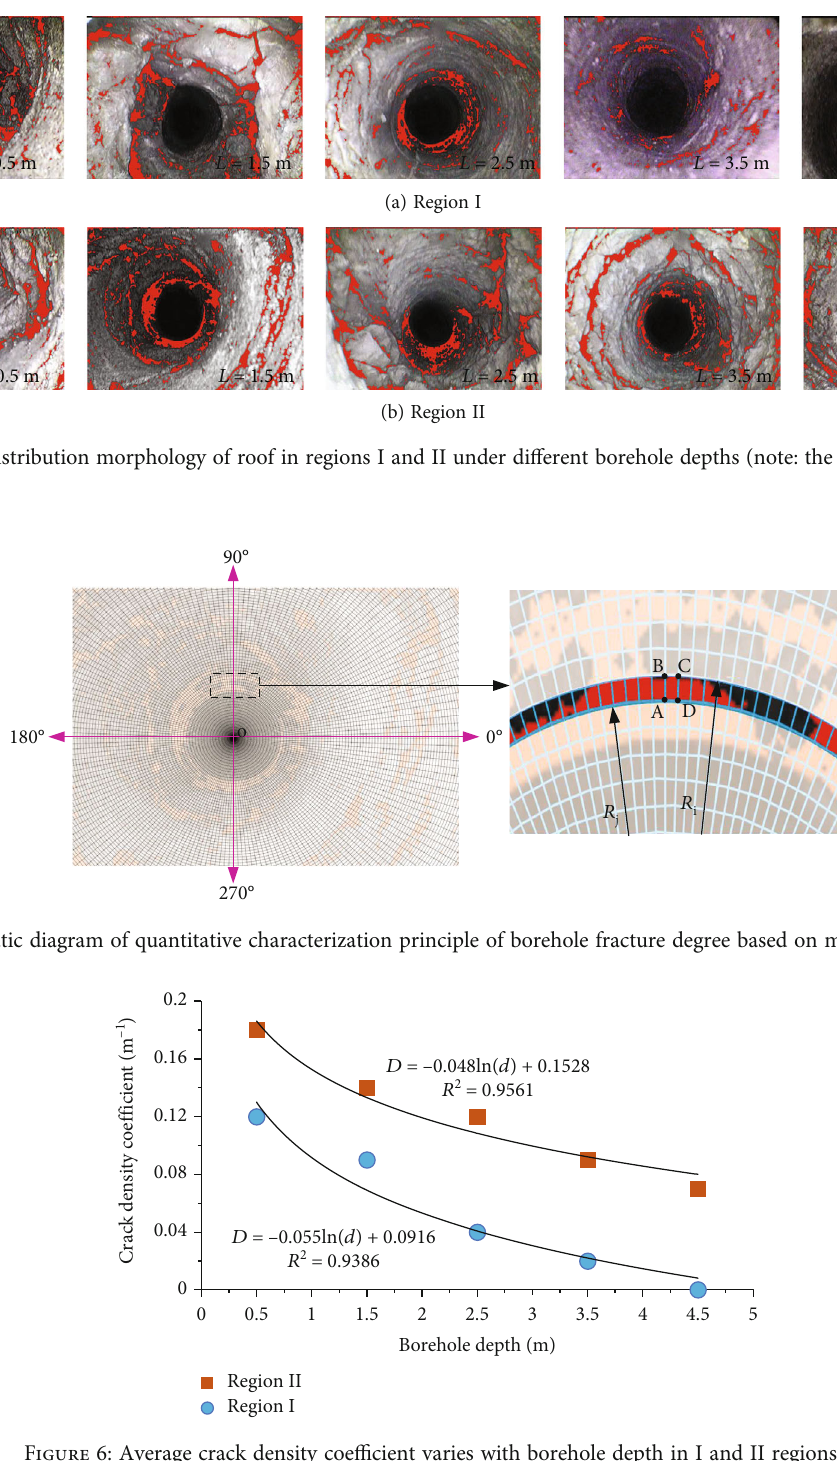
Figure 6: Average crack density coe ffi cient varies with borehole depth in I and II